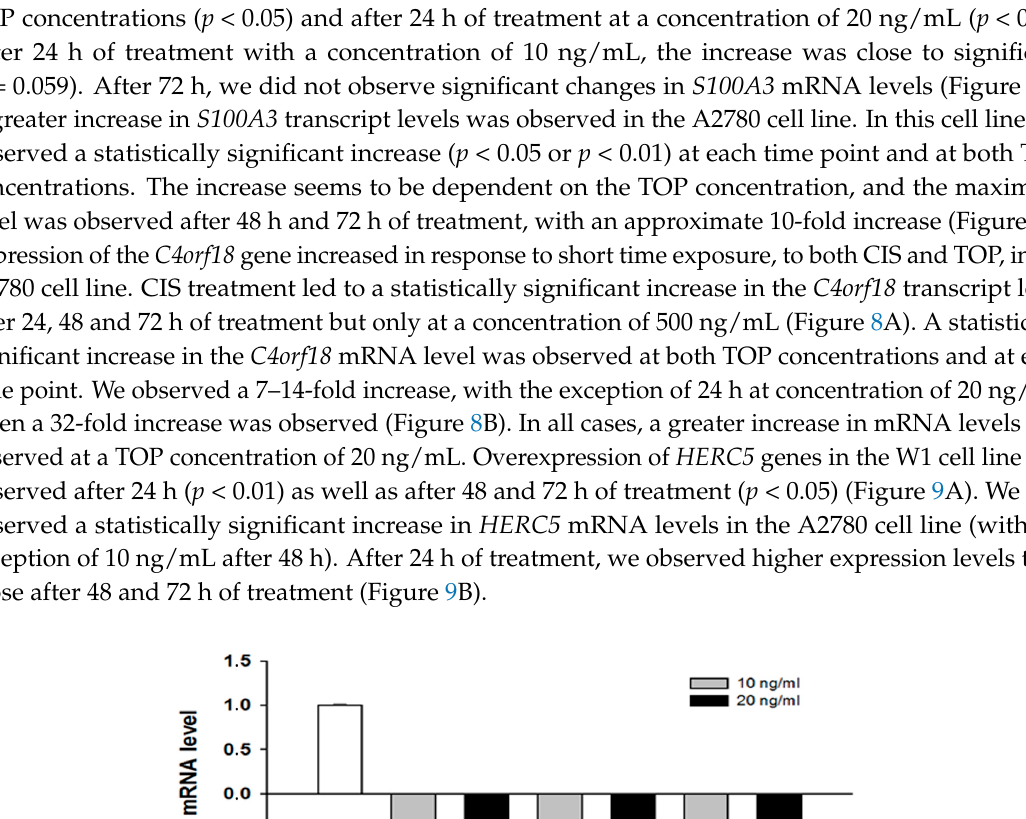
Figure 7. Expression analysis of the S100A3 gene in: W1 ( A ); and A2780 ( B ) ovarian cancer cell lines. The figure presents the relative gene expression in TOP-treated cells (grey and black bars) with respect to the untreated control (white bars), assigned as 1. The values were considered significant at * p < 0.05 and ** p < 0.01.